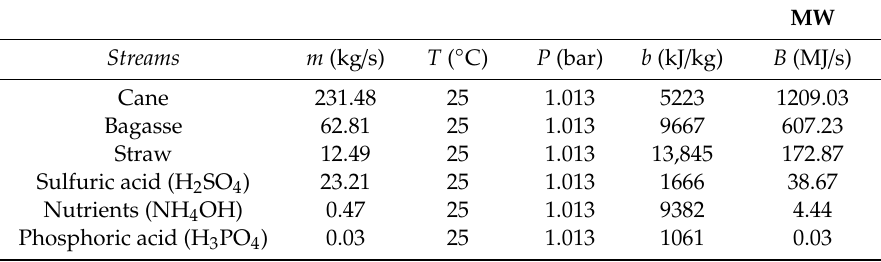
Table A16. Key streams parameters of the mass-integrated case (1G2G).